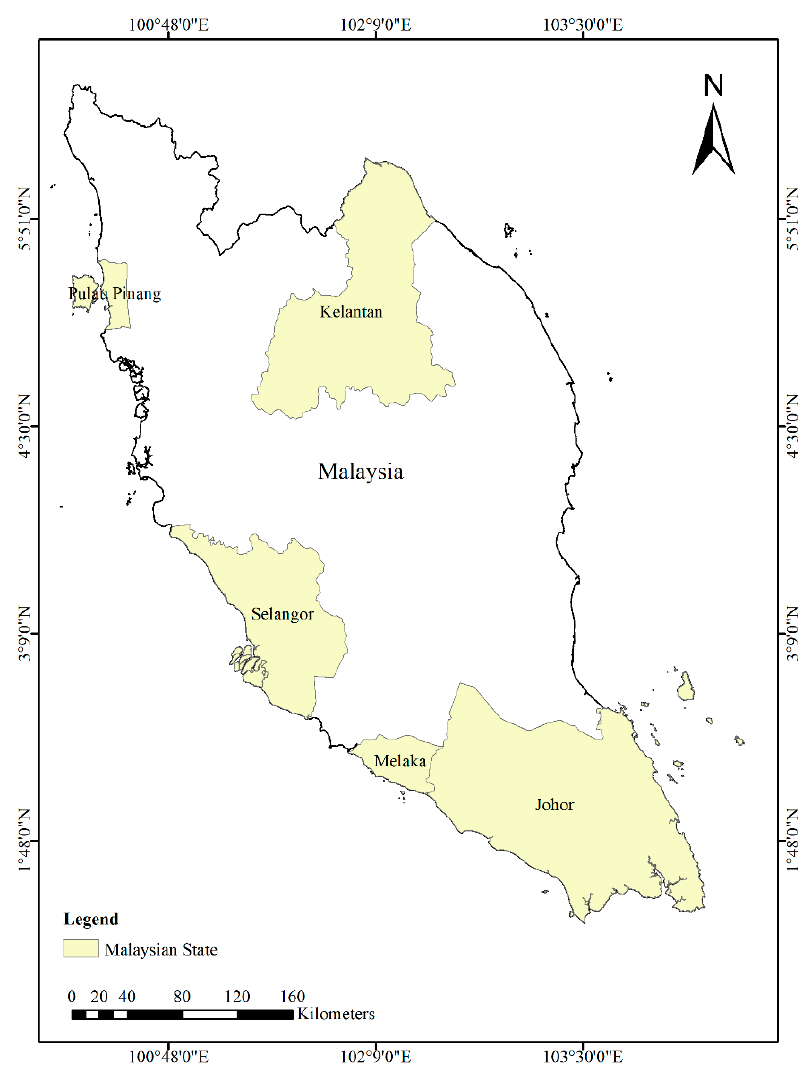
Figure 1. Map of Peninsular Malaysia showing the five states studied in this work.